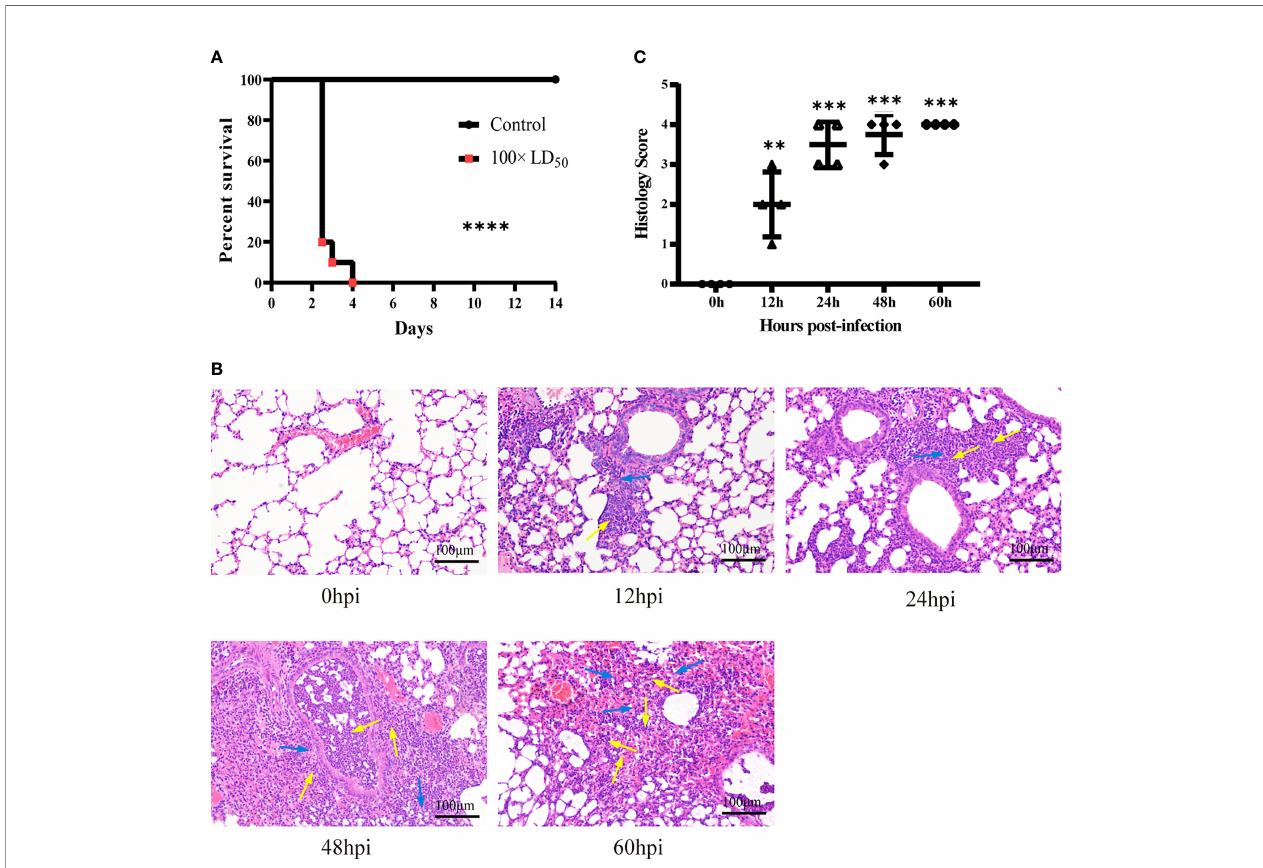
FIGURE 1 | Histopathological analysis of lung tissue from mice infected with hvKp. Mice were challenged with 100 × LD50 (20000 CFU) hypervirulent Klebsiella pneumoniae strain (NTUH-K2044), and then the lungs were stained with hematoxylin-eosin (HE). (A) Survival curves of mice in the infected and control groups (n=10 per group). **** p < 0.0001, compared with control group. (B) Pathological changes in the lungs at 0, 12, 24, 48 and 60 hours post-infection. Arrows show the in fi ltration of in fl ammatory cells; monocytes shown with blue arrows and neutrophils shown with yellow arrows (original magni fi cation = 200×; scale bar = 100 m m). (C) Pathological scores of the lung sections; symbols show individual mouse lung scores, horizontal and vertical lines indicate mean and standard deviations of group. Scoring standard: 0, no pathological lesions; 1, minimal; 2, mild; 3, moderate; 4, severe. The degree of pathological lesions was related to the distribution of lesions as follows: in fl ammatory cell in fi ltration, edema, congestion, and tissue necrosis. **P < 0.01, ***P < 0.001, compared with